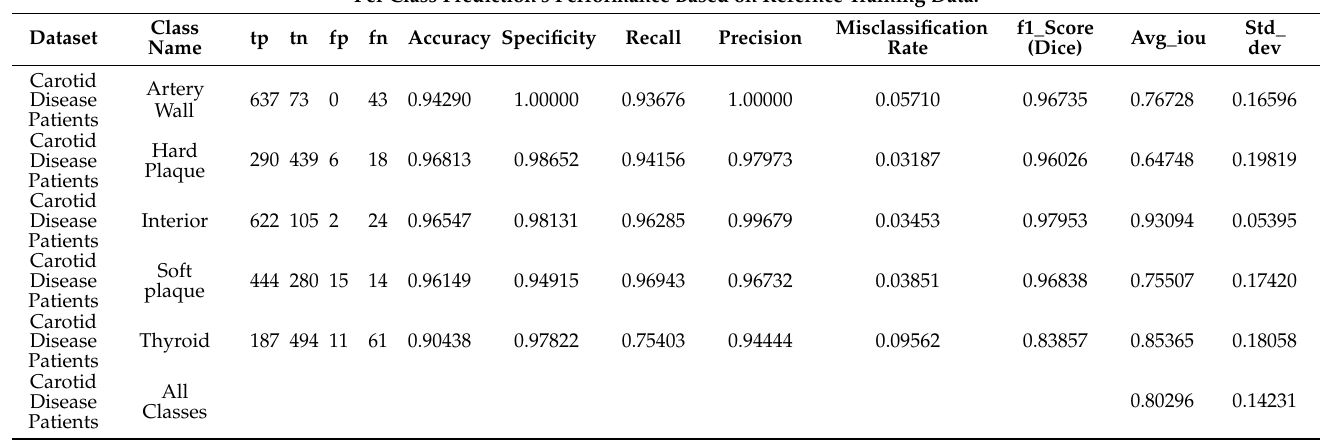
Table 3. Prediction performance based on reference training data, where, for the given dataset and tissue class name, tp represents the number of true positive predictions, tn represents the number of true negative predictions, fp represents the number of false positive predictions, and fn represents the number of false negative